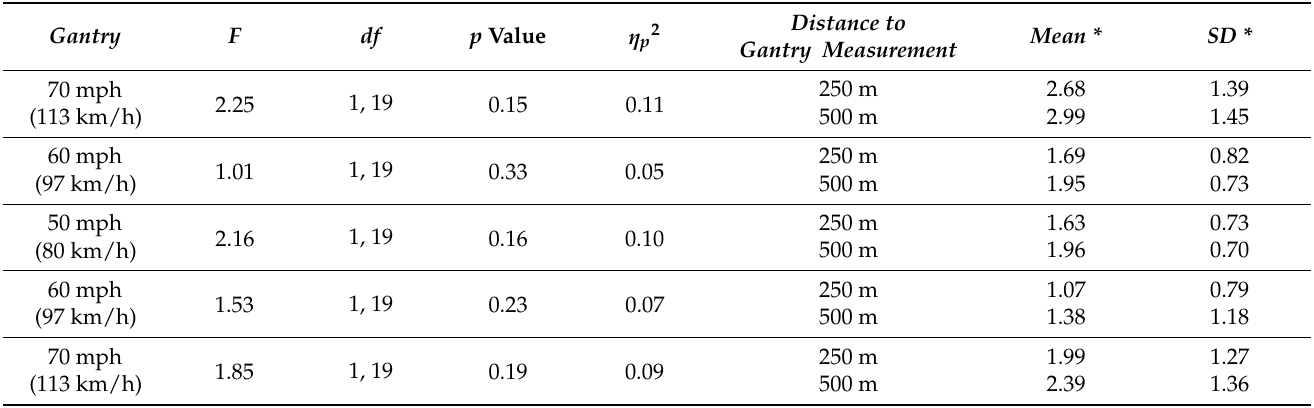
Table 10. Repeated measures ANOVA conducted to compare mean speed homogeneity within the baseline noHMI condition.